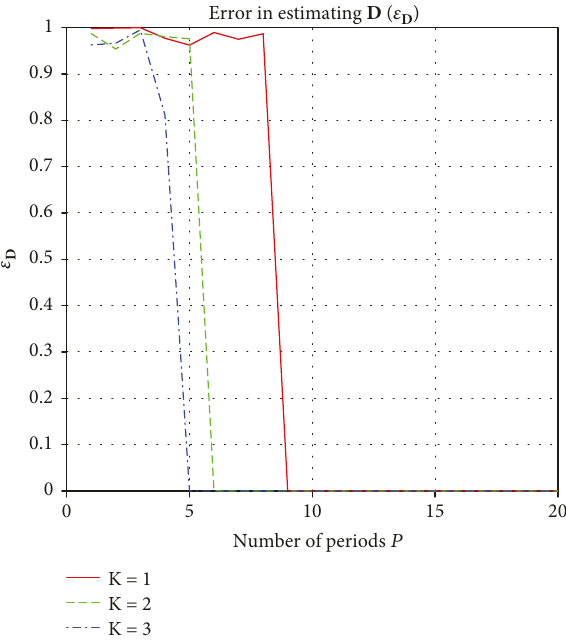
Figure 1: The error in estimating D as a function of the number of periods P , for different numbers of signals. Known DOAs, exact covariance matrices R p